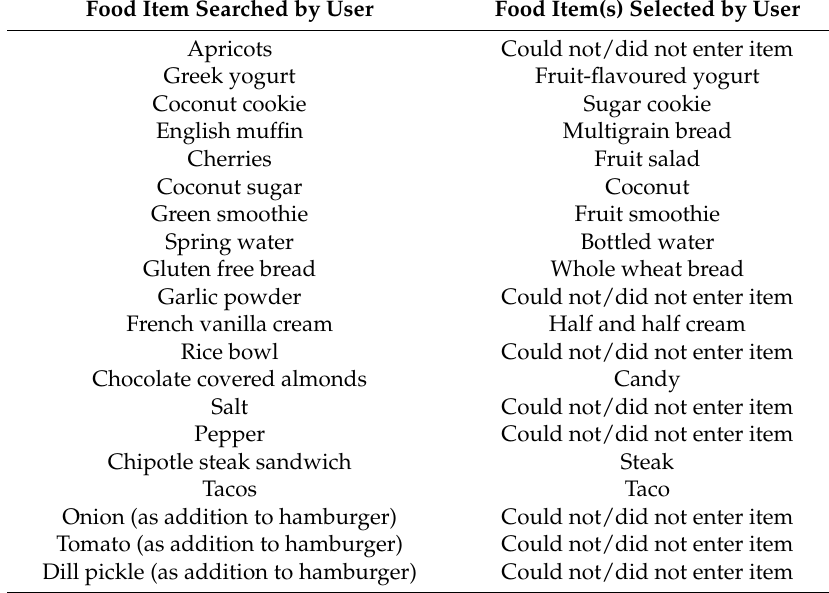
Table 5. Food items searched by the user that did not return the desired result, and the resulting food item selected by the